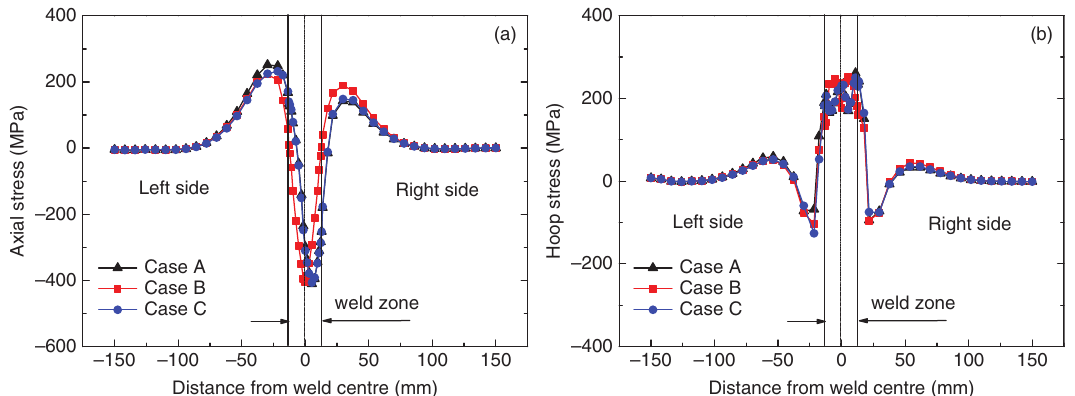
Figure 12: Residual stresses distributions at different welding sequences along path 3: axial stress (a), hoop